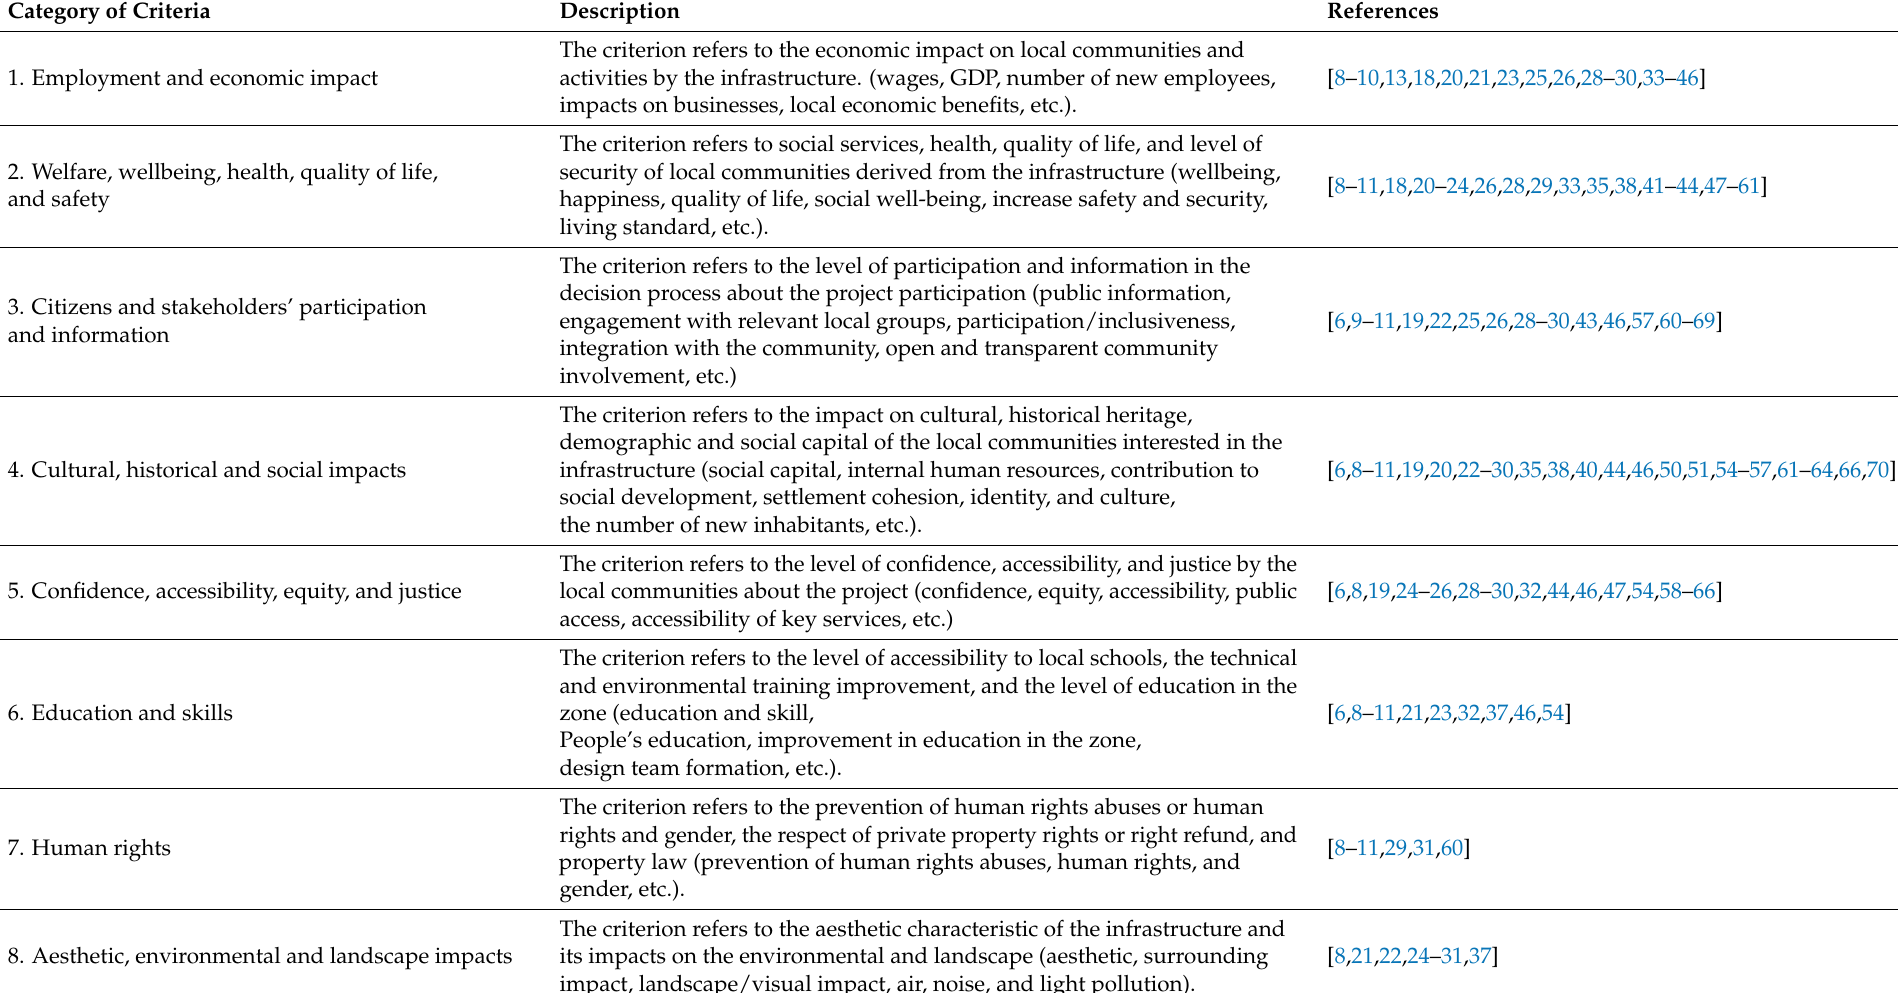
Table 1. Categories of criteria and